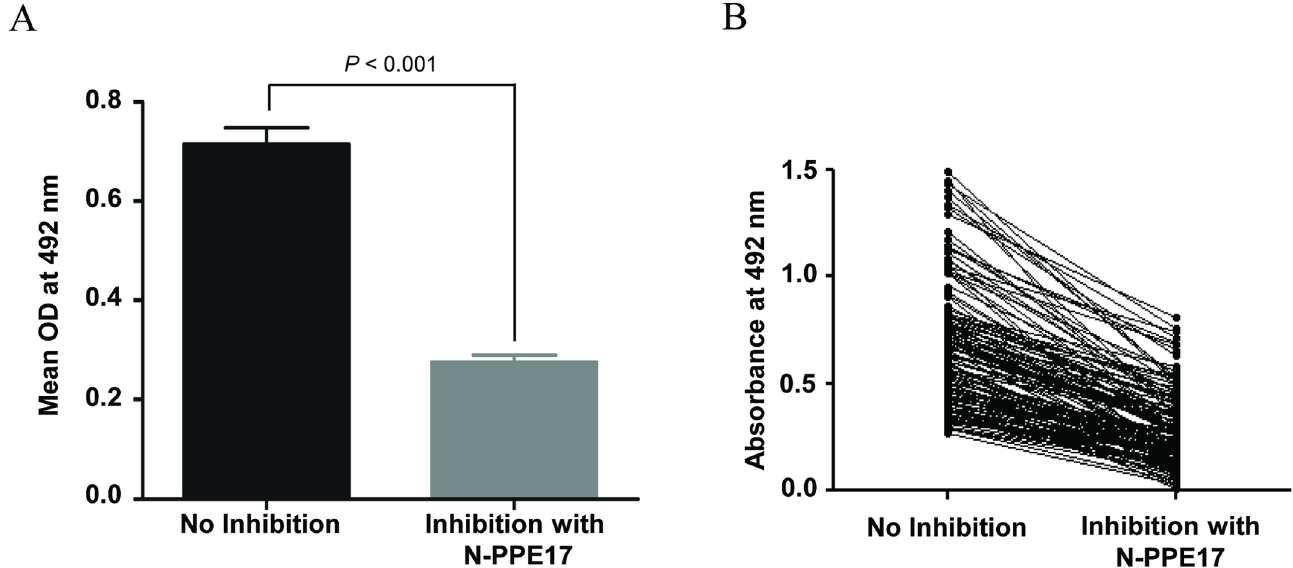
Fig 3. The N-terminal fragment of PPE17 (N-PPE17) is predominantly recognized by the sera of TB patients. (A) The EIA plates coated with full- length PPE17 protein were incubatedwith TB patients sera (n = 143) that were pre-incubated with 1 μ g of N-PPE17 protein dilutedin PBS followedby incubationwith anti-human IgG-HRP. The absorbance was read at 492 nm using the chromogenic substrate OPD. (B) The EIA absorbance values at 492 nm shown in Fig 3A were re-plottedfor individualsera samplesof active TB patients.